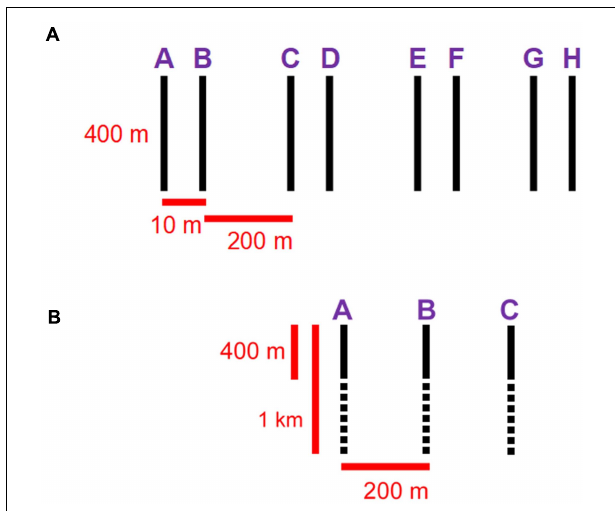
FIGURE 2 | (A) ROPOS sampling design: 8 400-m parallel transects, spaced at spatial lags of 10 m and pairs spaced at 200 m. (B) Campod sampling design: 3 1-km parallel transects spaced at 200 m; 400-m segments (solid back lines) were used for comparisons with ROPOS transects.